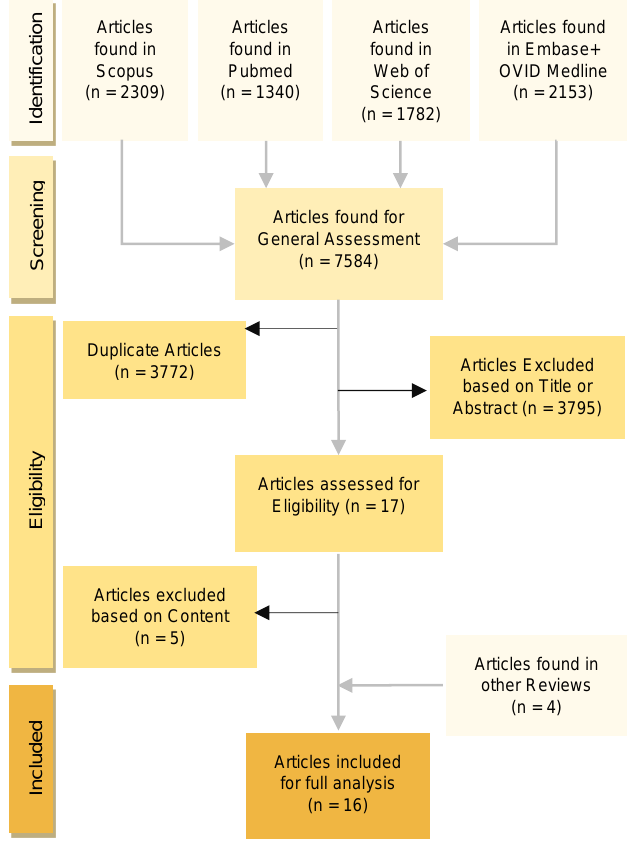
Figure 1: Flowchart diagram of the screening